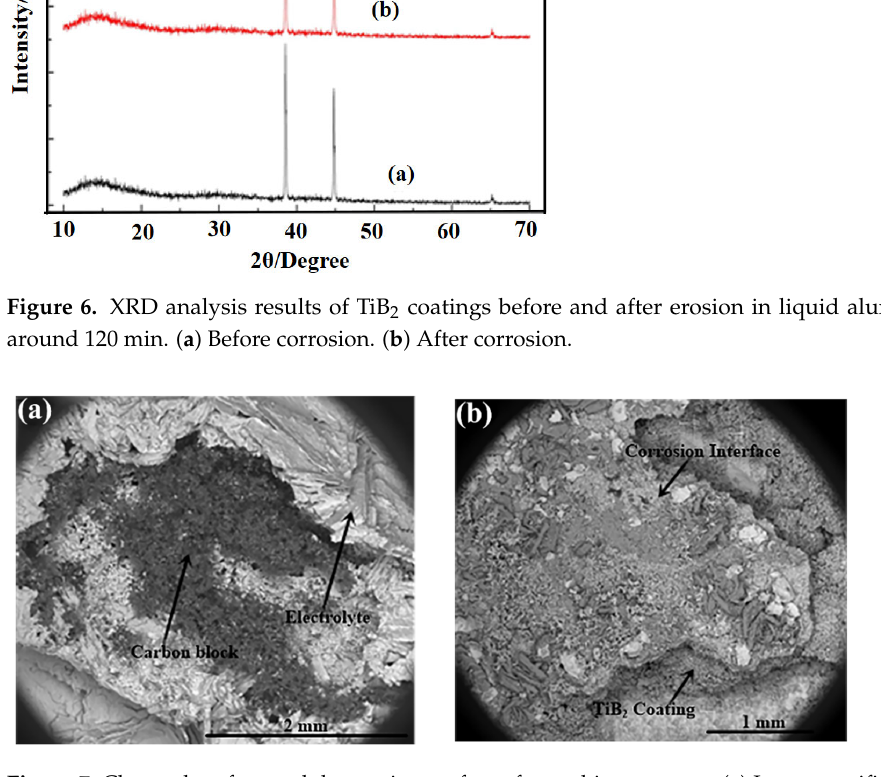
Figure 7. Charcoal surface and the coating surface after etching contrast. ( a ) Low magnification SEM image of sample surface after carbon block static corrosion, and ( b ) low magnification SEM image of TiB 2 coating surface after static corrosion.